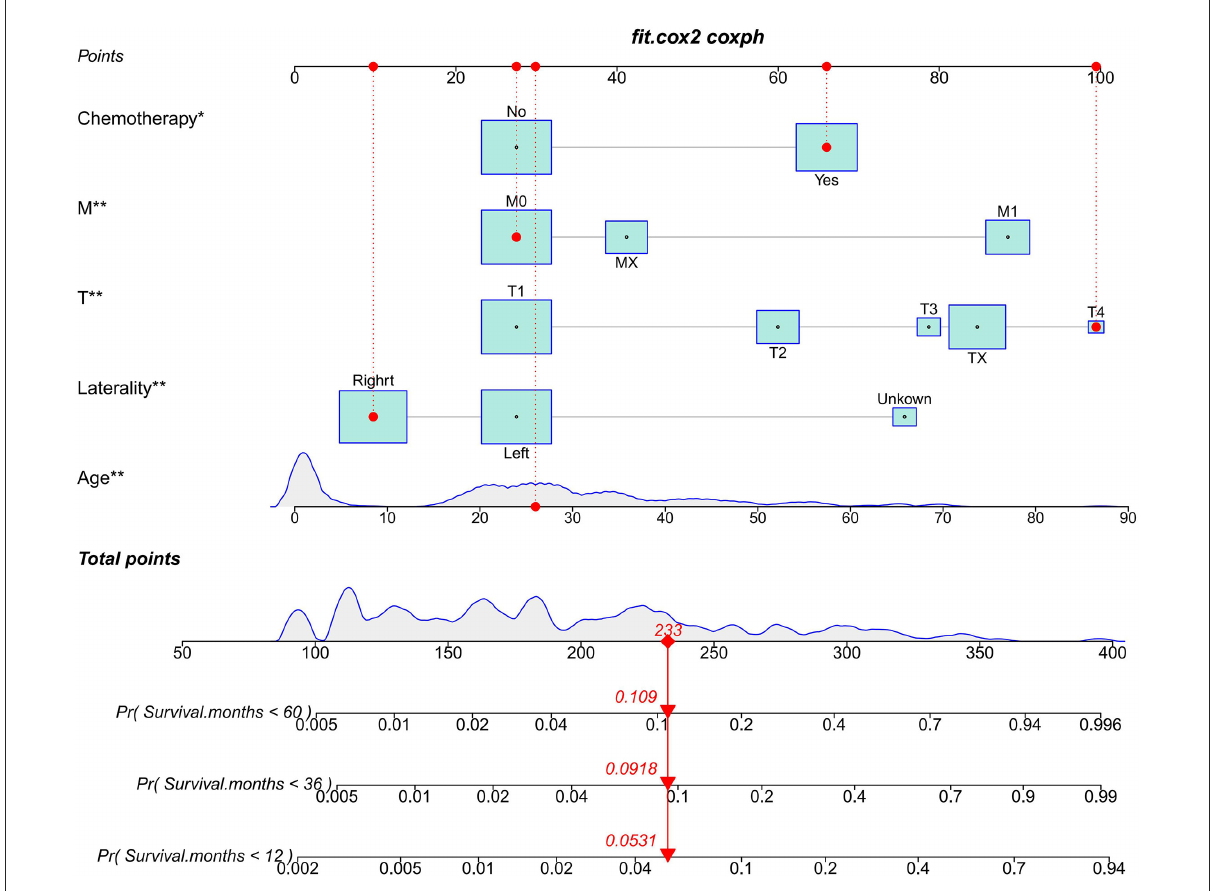
FIGURE2 The nomogram predicts CSS in patients with TYST at 1-, 3-, and 5-year. * P < 0.05, ** P < 0.01.